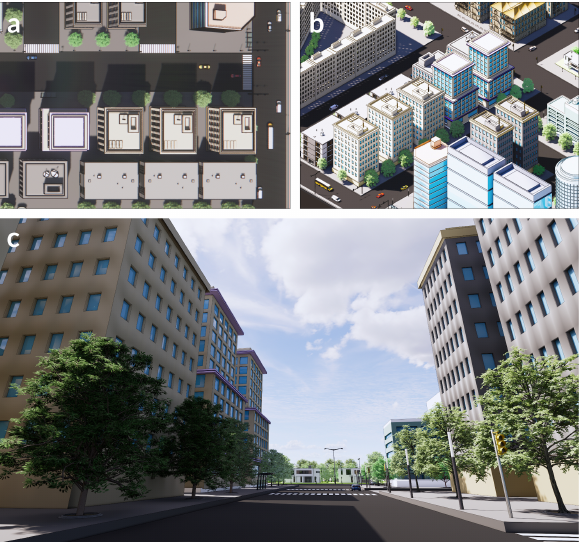
Figure 1. Illustration of some advantages and challenges of the perspective offered by SVI compared to traditionally used